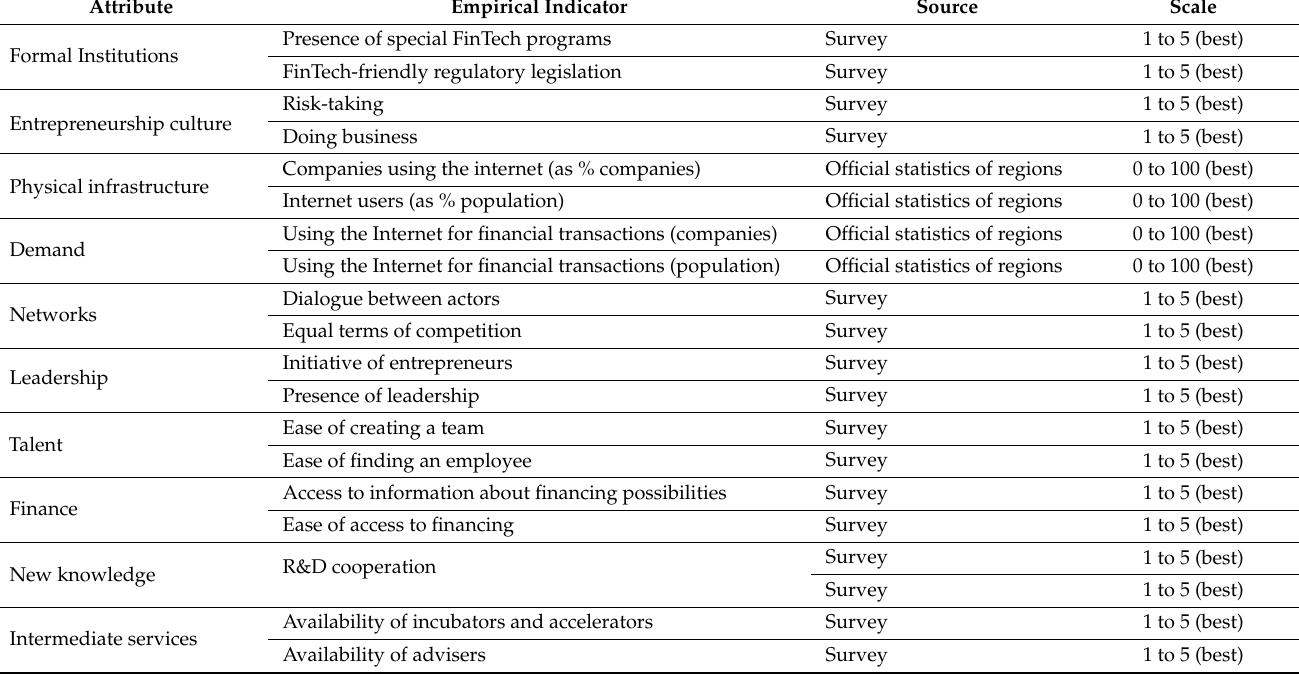
Table 4. Indicators for measuring the FE